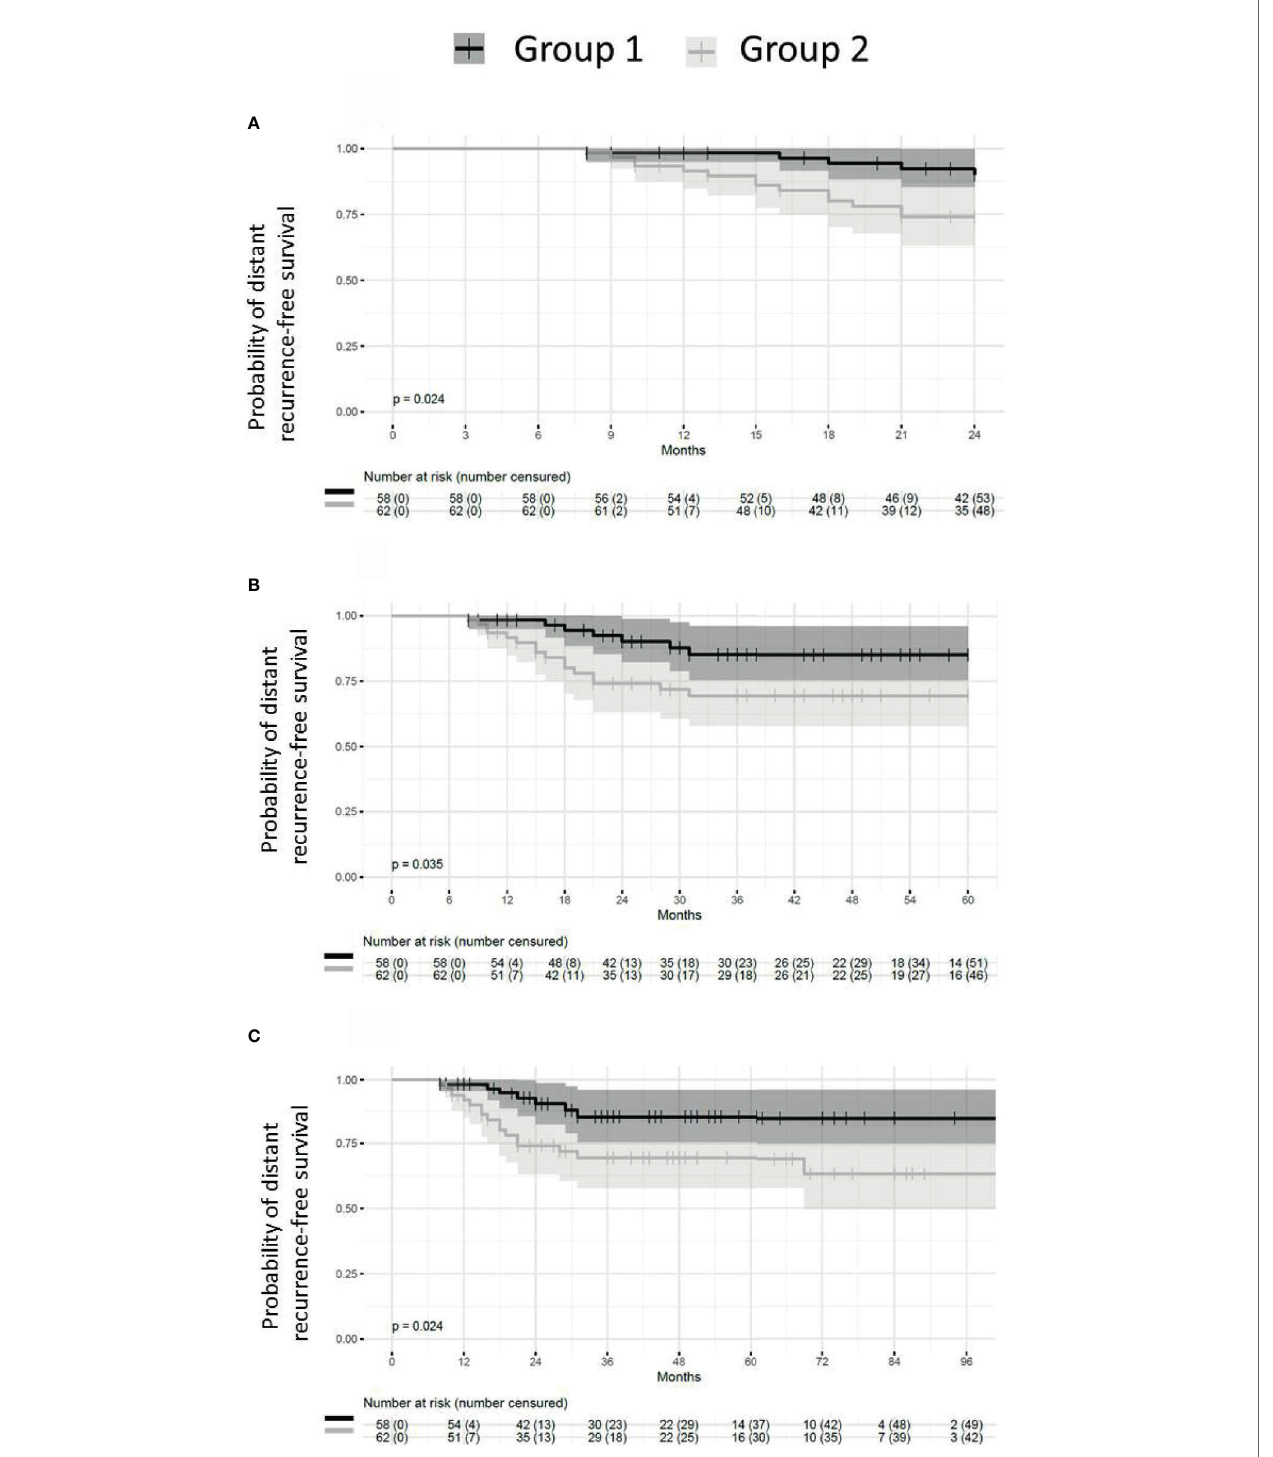
FIGURE 6 | Probability of distant recurrence-free survival from diagnosis. Patients with pCR or small residual disease (Group 1) after neoadjuvant chemotherapy exhibit better distant recurrence-free survival (DRFS) than patients with large residual disease (Group 2) (p = 0.024). (A) DRFS from diagnosis to 24 months (p = 0.024). (B) DRFS from diagnosis to 60 months (p = 0.035). (C) DRFS from diagnosis to 96 months (p =